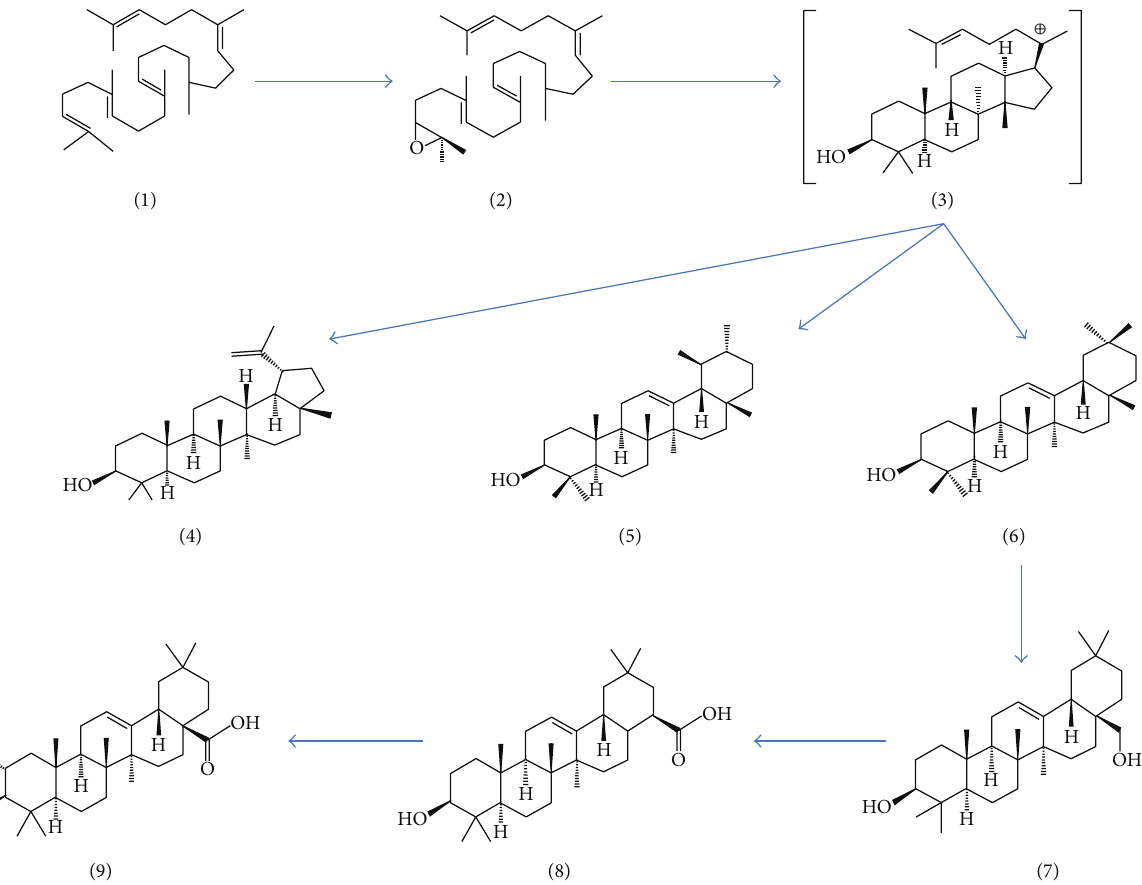
Figure 2: Biosynthesis of maslinic acid. Epoxidation of squalene (1) produces 2,3-oxidosqualene (2) which undergoes further cyclization into the dammarenyl cation (3). Dammarenyl cation undergoes D-ring expansion and additional cyclization to form products, such as lupeol (4), 𝛼 -amyrin (5), and 𝛽 -amyrin (6). Further oxidation steps convert 𝛽 -amyrin to erythrodiol (7), followed by oleanolic acid (8) and finally maslinic acid (9).